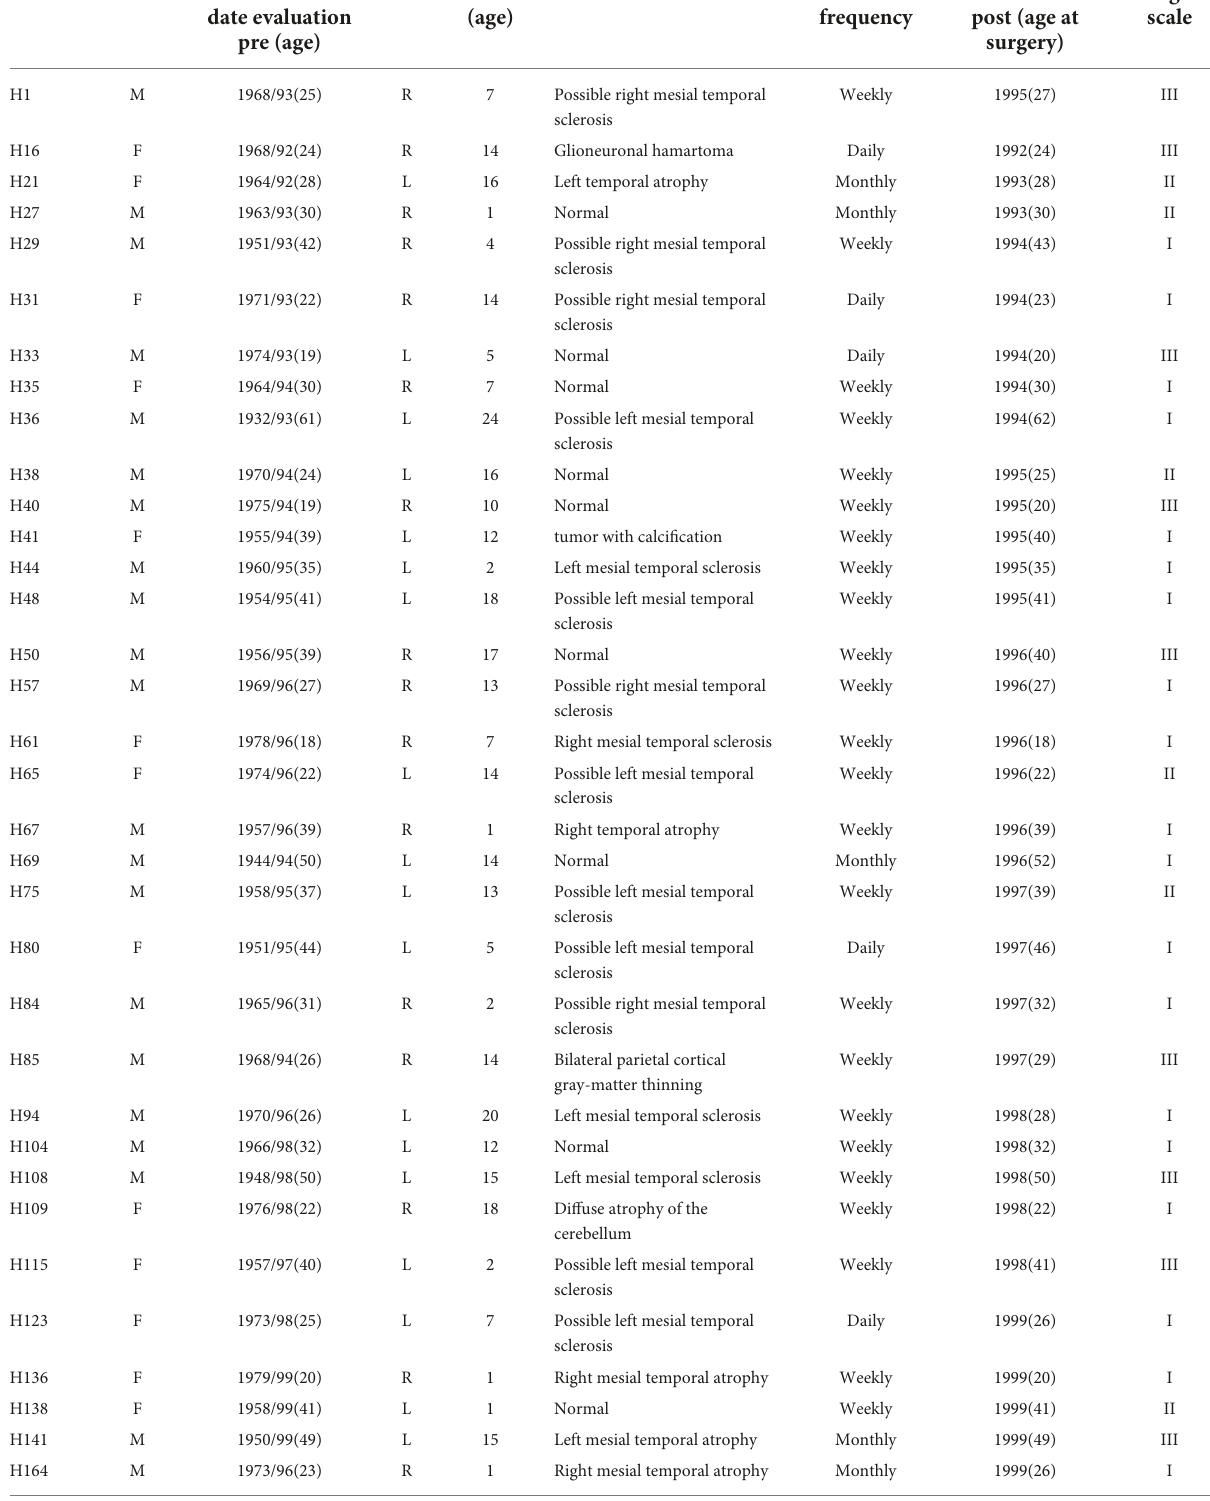
TABLE 1 Summary of the clinical data of the 34 epileptic patients analyzed including prognostic pathology by MRI and surgical outcome (Engel scale). Patient